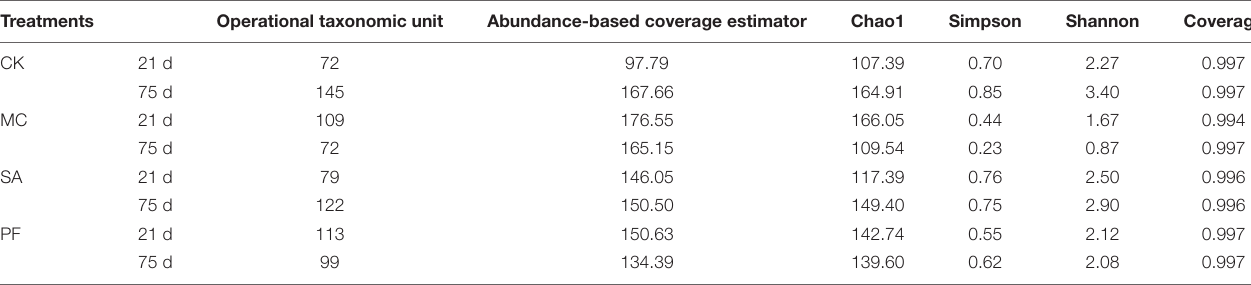
TABLE 3 | Alpha-diversity of bacterial diversity of paper mulberry silage. Treatments Operational taxonomic unit Abundance-based coverage estimator